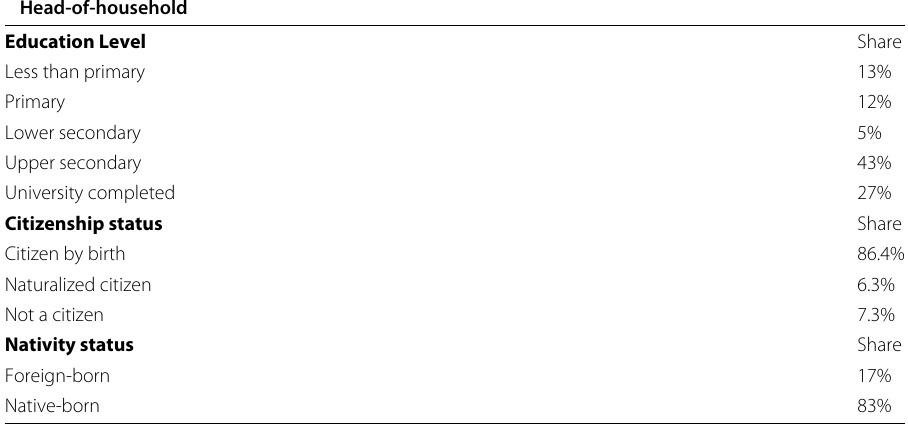
Table 3 Distribution of individuals according to their head-of-household variables (full sample, %)